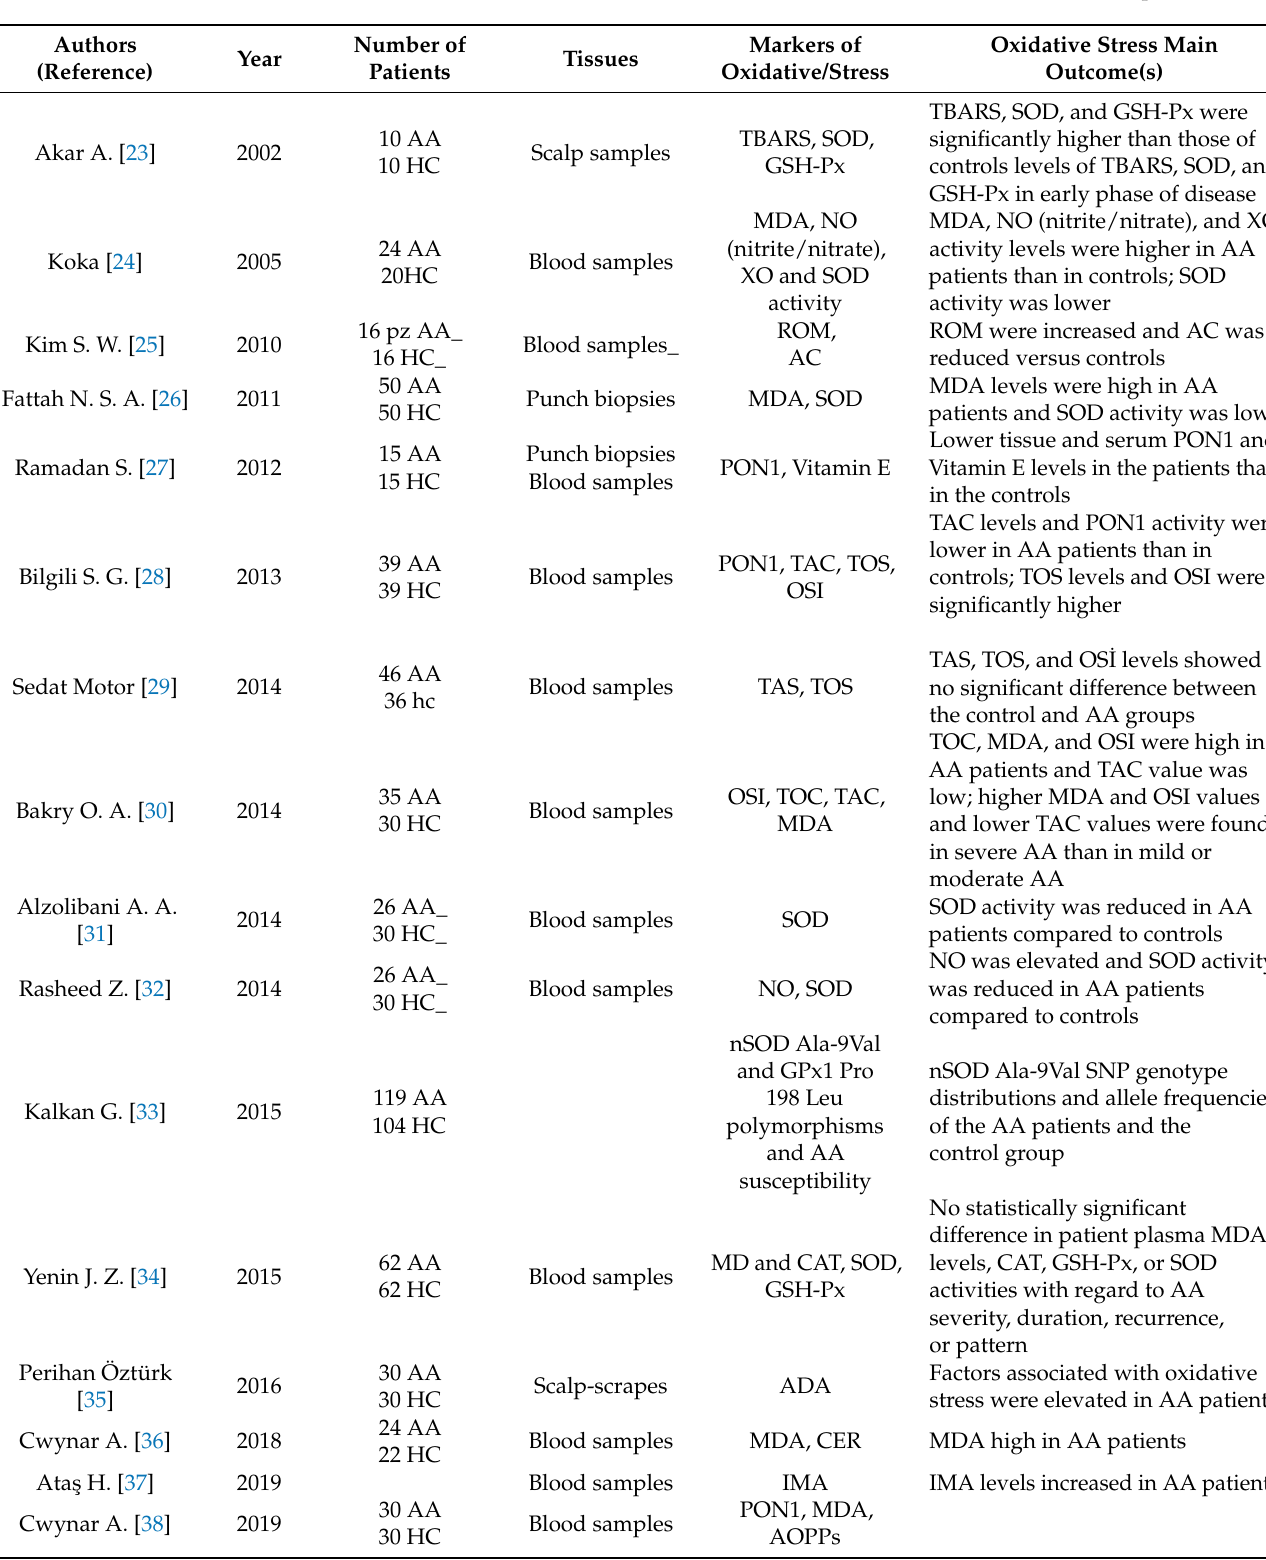
Table 1. Summary of the articles concerning AA and OS in chronological order, from oldest to most recent. For each study, in addition to the author and year of publication, the number of patients, tissues, markers of oxidative stress, and oxidative stress main outcome(s) are also